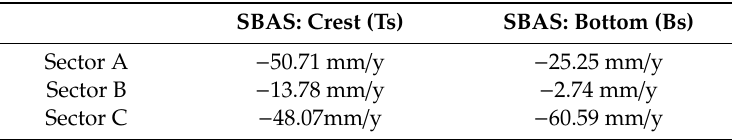
Figure 7. Time-series of SBAS line of sight (LoS) displacements for selected measured points (MPs) located at three selected points of the dam, as presented in Figure 5a, showing the highest cumulative displacements for the entire period of monitoring and the linear regression of the data (letters A, B, and C are the displacement trends as discussed in the text). Table 2. SBAS deformation rate for each